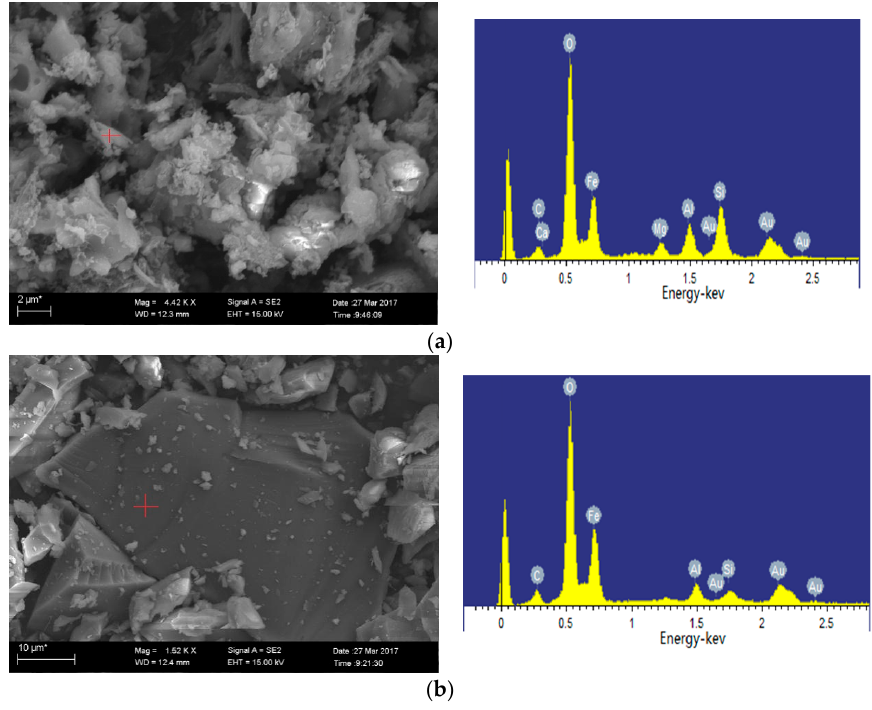
Figure 7. Minerals in reduction ash of Ulanqab lignite (SEM-EDS, secondary electron images).